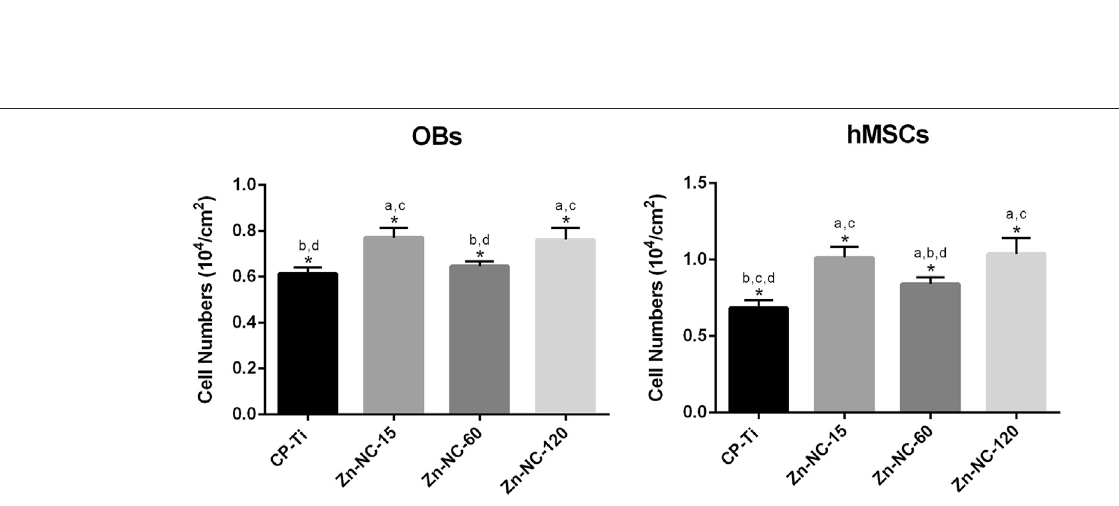
Frontiers in Materials |